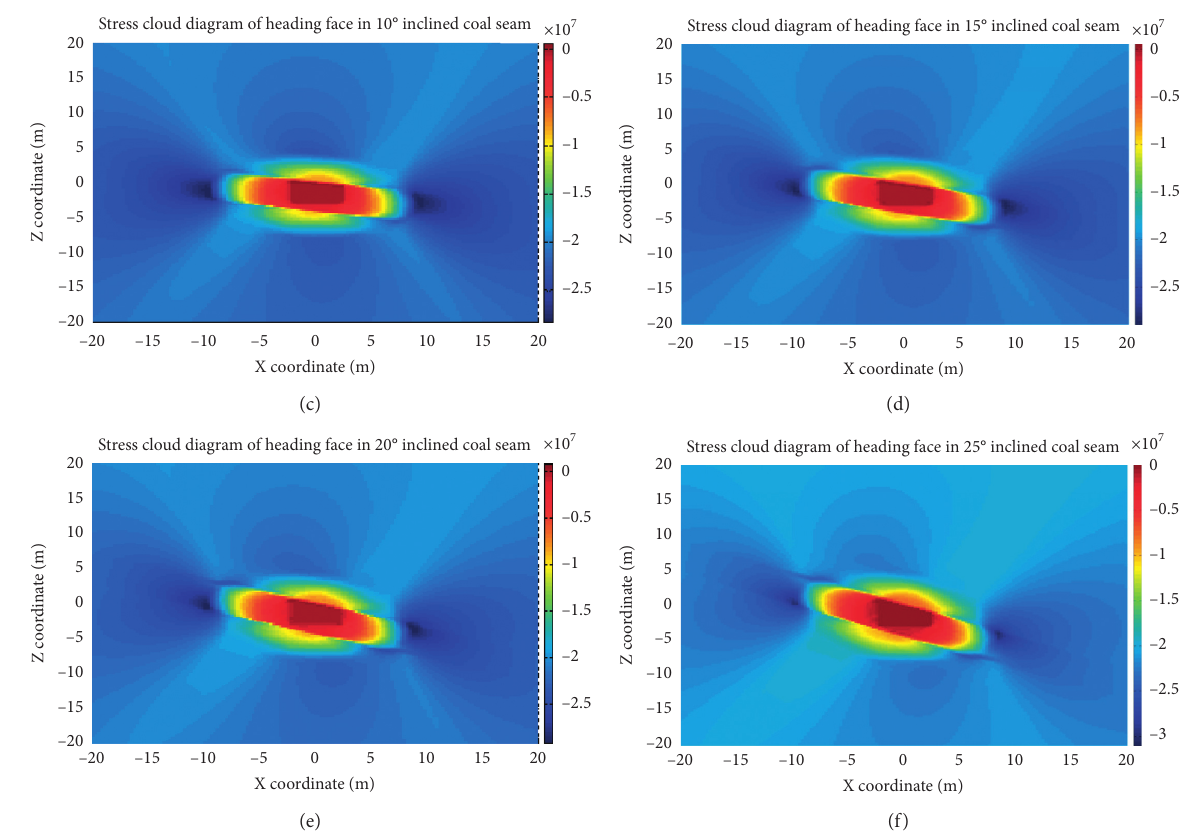
Figure 2: Plane cloud diagram of the section stress of the roadway heading head under each coal seam